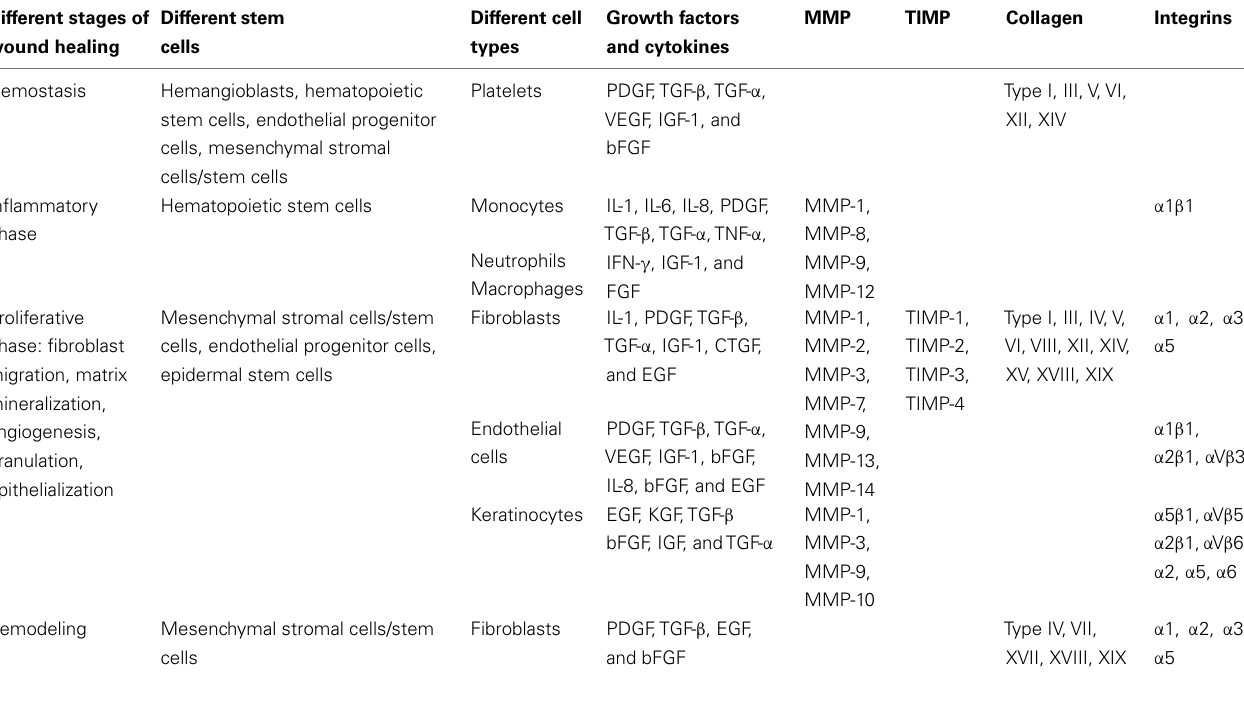
Table 1 | Regulators of the wound healing